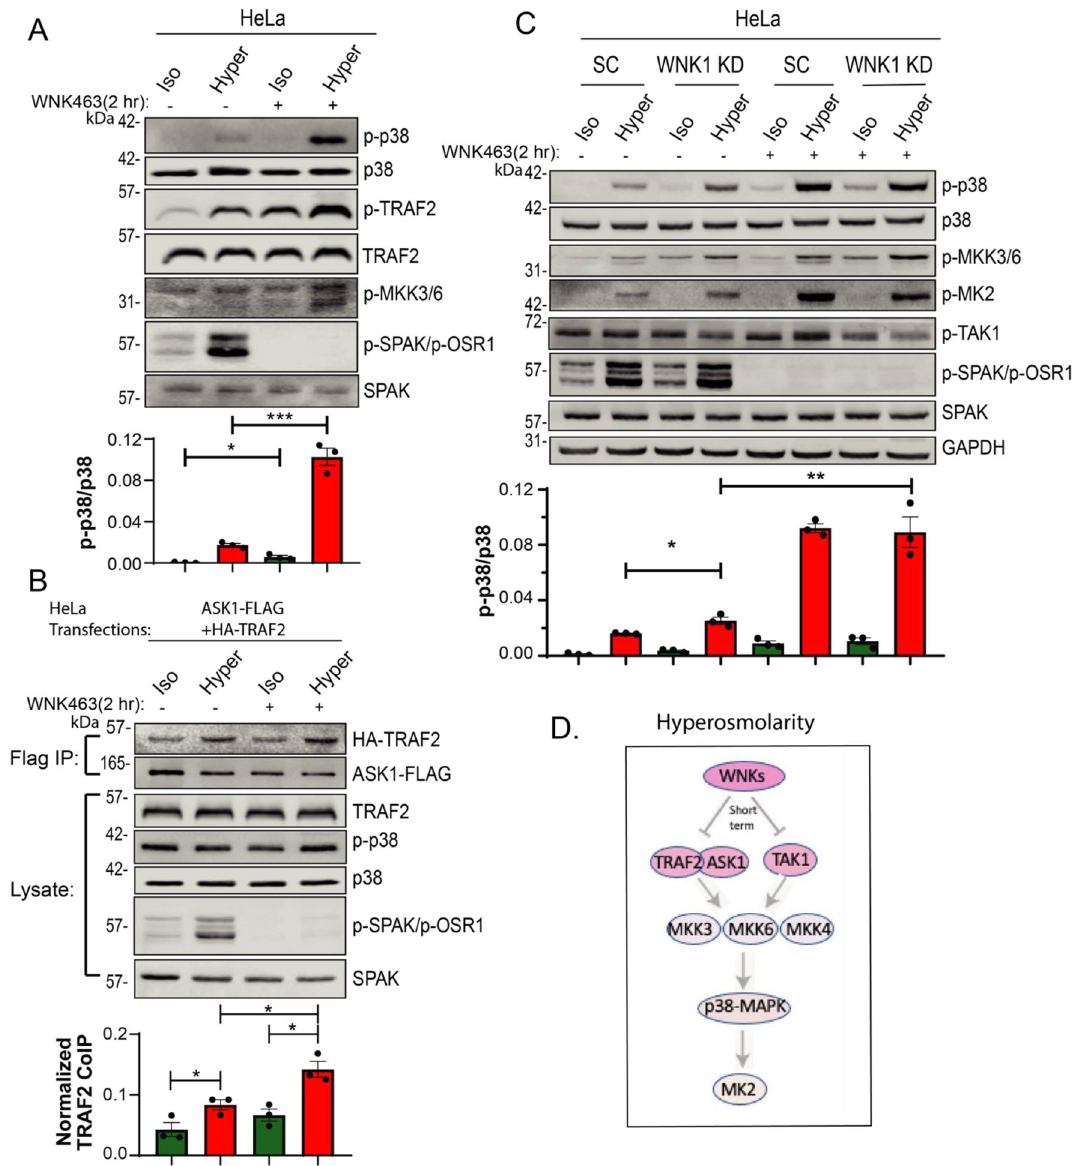
Figure 3. Short-term inhibition of WNK kinases, or WNK1 depletion, induces ASK1/TRAF2 interactions and p38 activation. ( A ) HeLa cells were pretreated without or with 10 μM pan-WNK inhibitor (WNK463) for 2 h followed by incubation with iso- or hyper- osmotic NaCl solutions for 15 min in the absence/presence of WNK463. ( B ) HeLa cells were transfected with ASK1-Flag and HA-TRAF2 for 48 h and then treated with 10 μM WNK463 for 2 h, followed by incubation in either iso- or hyper- osmotic NaCl solutions for 15 min in the absence/presence of WNK463. ASK1-FLAG was immunoprecipitated with FLAG affinity beads and TRAF2 co-immunoprecipitation was determined by immunoblotting for TRAF2. ( C ) WNK1 stable knockdown (or scramble control, SC) in HeLa cells were treated (or not) with 10 μM WNK463 for 2 h followed by incubation with the indicated NaCl solutions for 15 min in the absence/presence of WNK463. Quantification of active p38 (p-p38) or co-immunoprecipitated TRAF2 is depicted below their respective blots. All data are mean ± s.e.m, N = 3 independent experiments. Statistics as described in Fig. 1. ( D ) A model depicting a short-term WNKs- mediated suppression of the p38 pathway under hyperosmotic